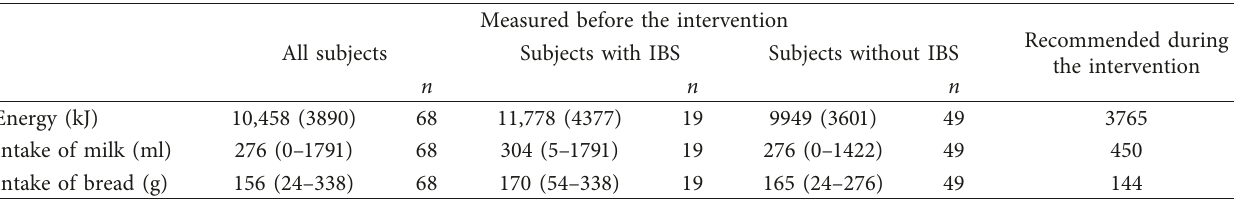
Table 5: Comparison of intake of energy, bread and milk, before and during the last three weeks of the intervention. Measured before the intervention interventionAll subjects Subjects with